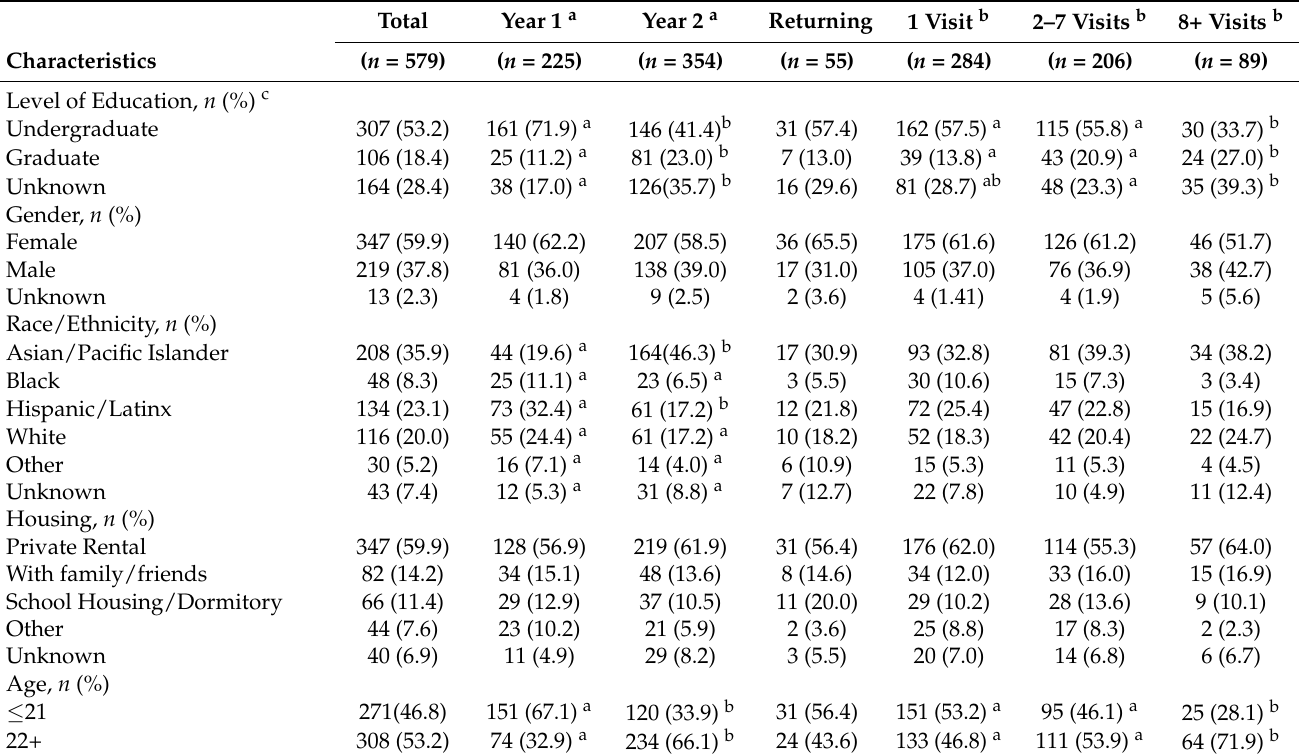
Table 3. Summary of demographic characteristics among students, by year, returning students,